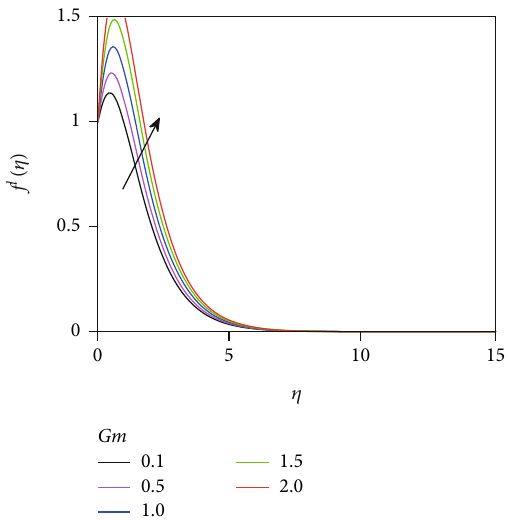
Figure 10: Signi fi cance of the thermal Grashof number on velocity plot.